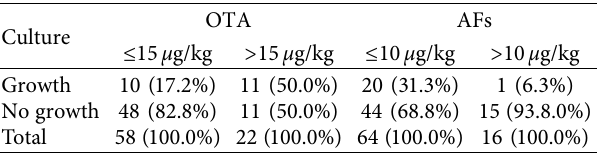
Table 5: The frequency of samples contaminated with mycotoxins based on culture